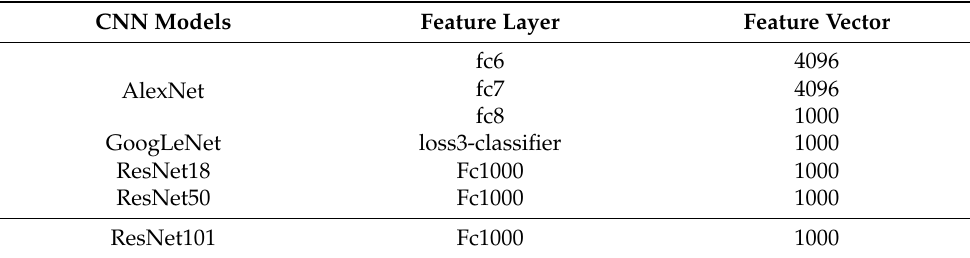
Table 2. The deep feature layer and feature vector of the studied CNN network.